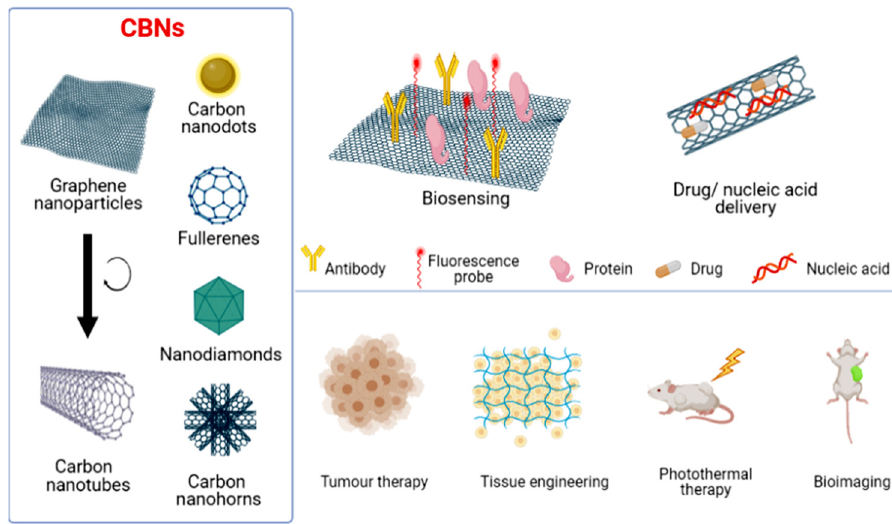
Figure 6: CBNs including graphene NPs and its wrapping structure carbon nanotubes, carbon nanodots, fullerenes, nanodiamonds, and carbon nanohorns. Thanks to the possibility to conjugate fl uorescence molecules, antibodies, proteins, drugs, or nucleic acids, CBNs can be employed in tumour therapy, tissue engineering, photothermal therapy, and